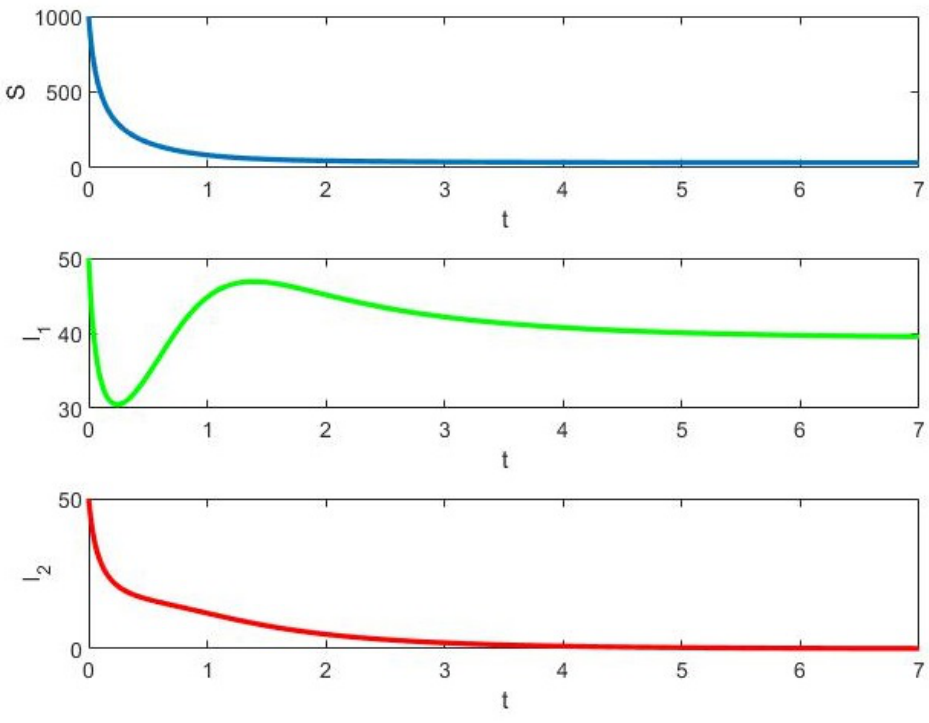
Figure 1. Example 1: deterministic solution for S ( 0 ) = 1000, I 1 ( 0 ) = I 2 ( 0 ) =